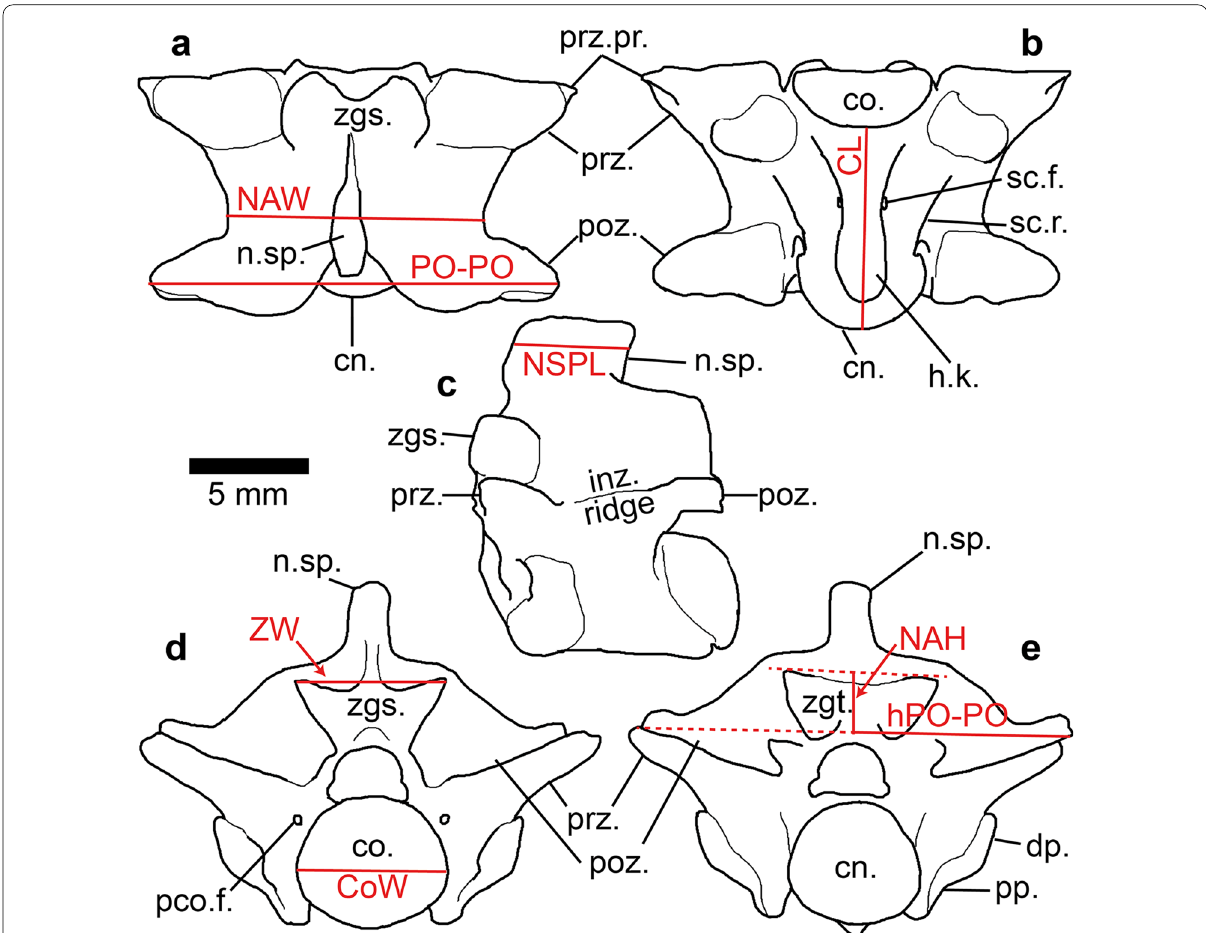
Fig. 1 Generalized figure of the vertebral anatomy of Constrictores, based on a trunk vertebra of Boa constrictor (specimen SMF-PH 40). Anatomical structures labelled in black and measurements labelled in red. CL, centrum length, measured ventrally and including the condyle; cn., condyle; co., cotyle; CoW, cotyle width; dp., diapophysis; h.k., haemal keel; hPO-PO, half-width of distance between the outer edges of the postzygapophyses; inz. ridge, interzygapophyseal ridge; NAH, neural arch height; NAW, neural arch width, measured at the maximum interzygapophyseal constriction; nsp., neural spine; NSPL, neural spine length; pco.f., paracotylar foramen; poz., postzygapophysis; PO-PO, distance between the outer edges of the postzygapophyses; pp., parapophysis; prz., prezygapophysis; prz. pr., prezygapophyseal accessory process; sc.f., subcentral foramen; sc.r., subcentral ridge; zgs., zygosphene; zgt., zygantrum; ZW, zygosphene